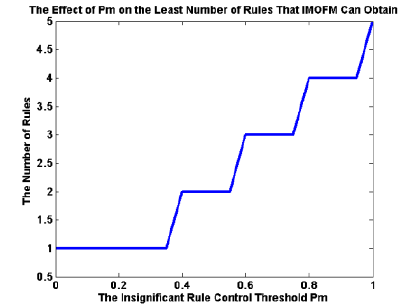
Fig. 13. The effect of on the least number of rules that IMOFM can obtain.